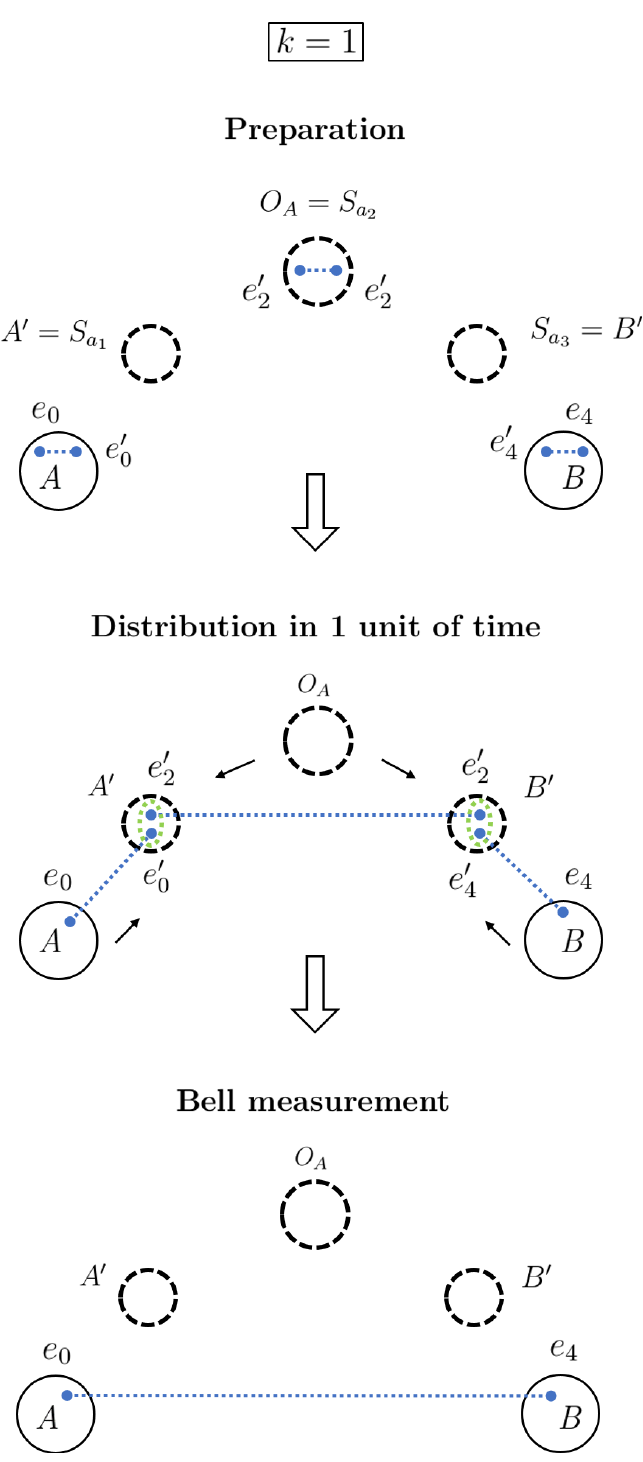
Figure 6. An illustration of the protocol for k = 1. Nodes A , O A and B locally prepare entangled pairs of qubits. Nodes A (cid:48) and B (cid:48) each receive two qubits (from A and O A and from O A and B , respectively). A Bell measurement can then be performed on the qubits from different entangled pairs, regardless of the order, followed by classical communication of outcome (not pictured). For example, A (cid:48) is the first to perform a Bell measurement, followed by B (cid:48) . After these steps, entanglement has propagated via swapping towards Alice and Bob, who finally share one ebit as entangled pair ( e 0 , e 4 )